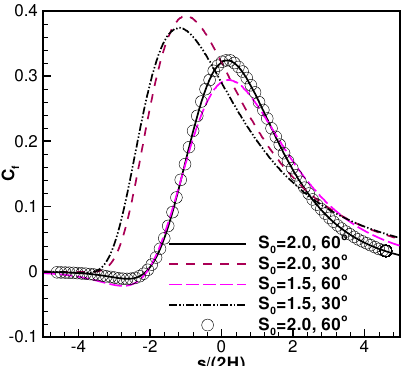
Figure 9. Diffuse planar plate: surface C f , d ( s ) , T w / T 0 = 1.5. Lines: analytical; symbols: DSMC.